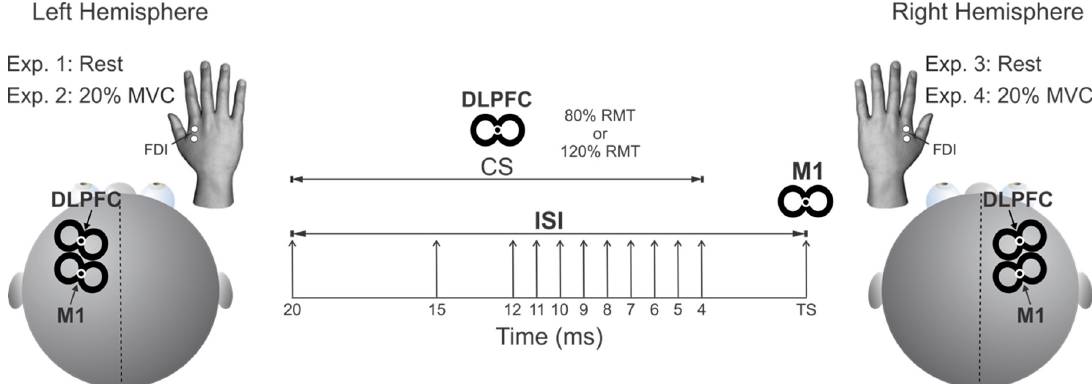
Figure 1. Experimental protocol. The conditioning stimulus (CS) coil was applied to the dorsolateral prefrontal cortex (DLPFC) and the test stimulus (TS) coil was applied to primary motor cortex (M1) in the left (Experiments 1 and 2) and right hemispheres (Experiments 3 and 4). DLPFC-ipsilateral M1 interactions were probed while participants were at rest or maintaining a 20% maximum voluntary contraction (MVC) of the left and right first dorsal interosseous (FDI) muscles. The CS intensity was 80% or 120% of resting motor threshold (RMT). The interstimulus interval (ISI) between pulses were 4, 5, 6, 7, 8, 9, 10, 11, 12, 15 or 20 ms.